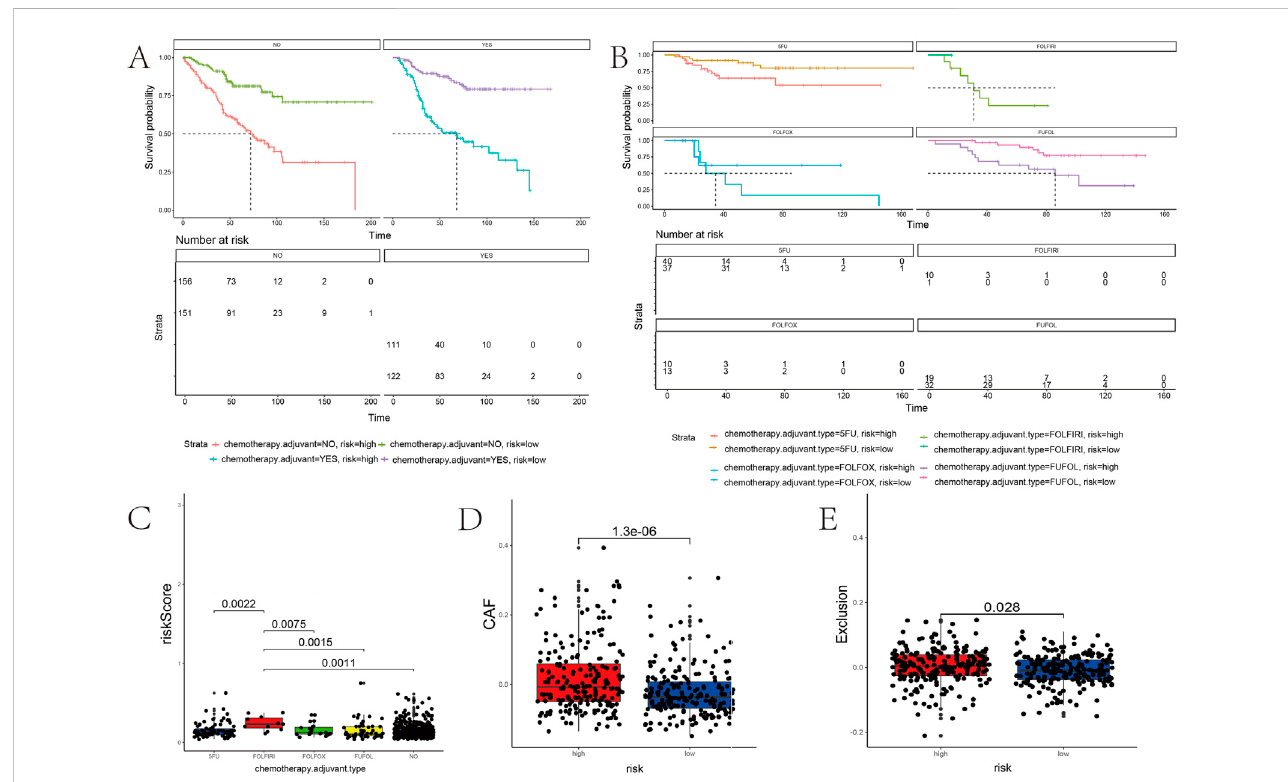
FIGURE 9 Association between the risk score and the adjuvant chemotherapy and immunotherapy response of PD-1. (A,B) Kaplan – Meier curves strati fi ed by quartiles of risk scores and the usage of adjuvant chemotherapy. (C) Correlation of the risk score with a chemotherapy drug. (D,E) Risk score positively correlated with CAF and immune